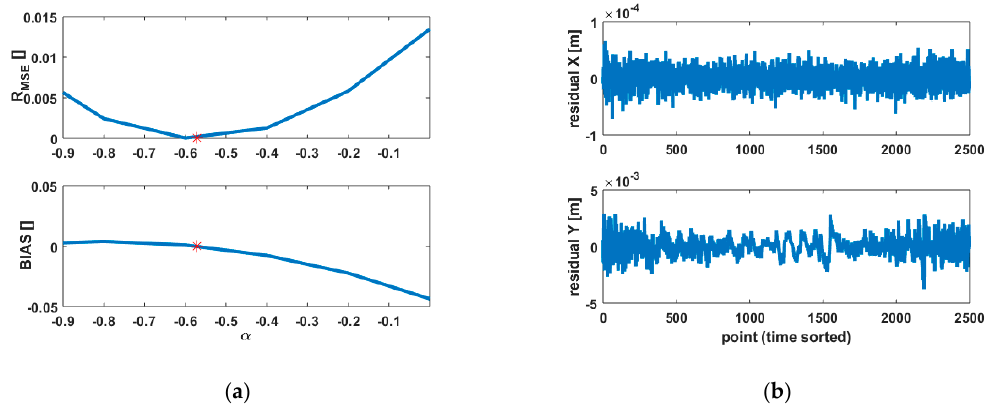
Figure 6. Results from a real case study with known noise vector. ( a ) R MSE and BIAS of the a posteriori variance factor. The red star corresponds to the reference parameters α 0 ; ( b ) residuals for the X ( up ) and Y ( bottom ) components. The Monte Carlo algorithm to compute the knot vector was used for a better accuracy of the B-splines approximation.